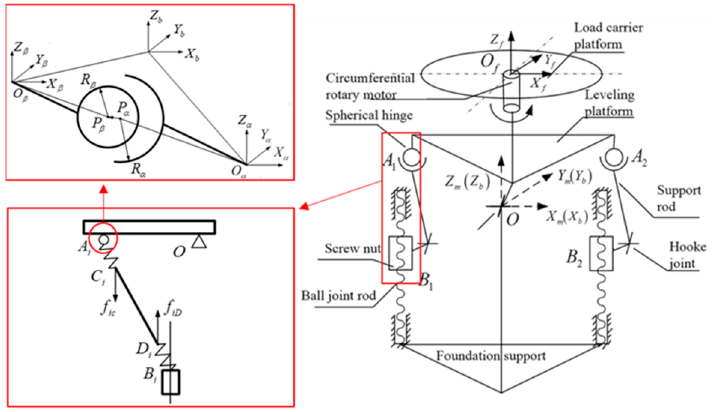
Figure 3. Schematic diagram of an unmanned platform stabilization mechanism.